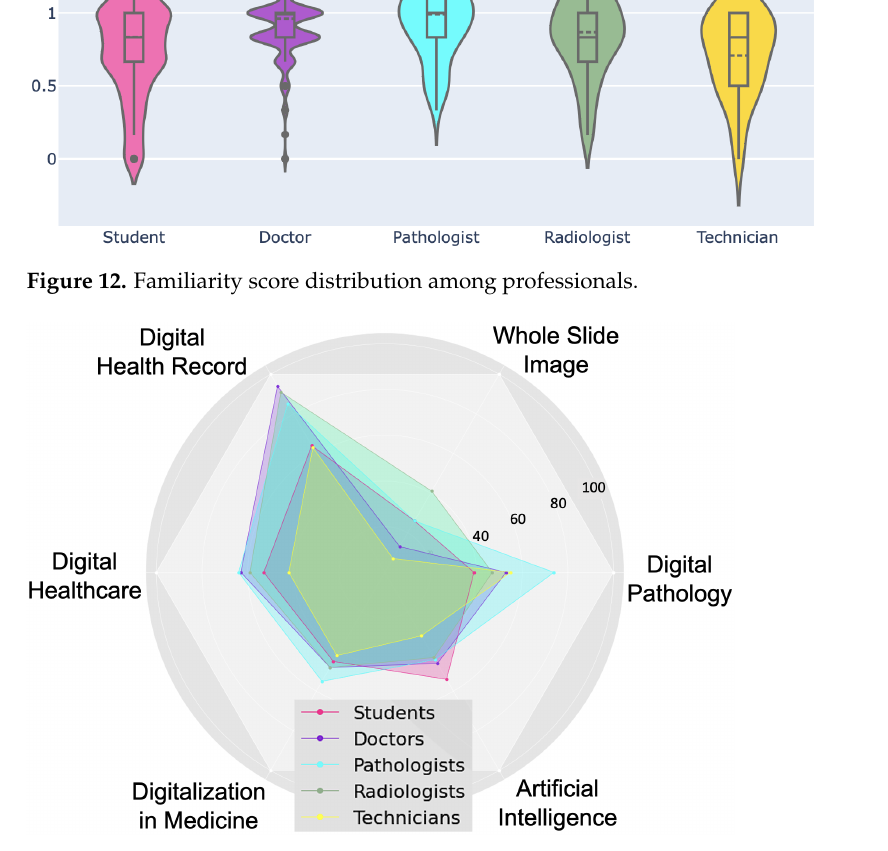
Figure 13. Overall familiarity with digital health literacy-related